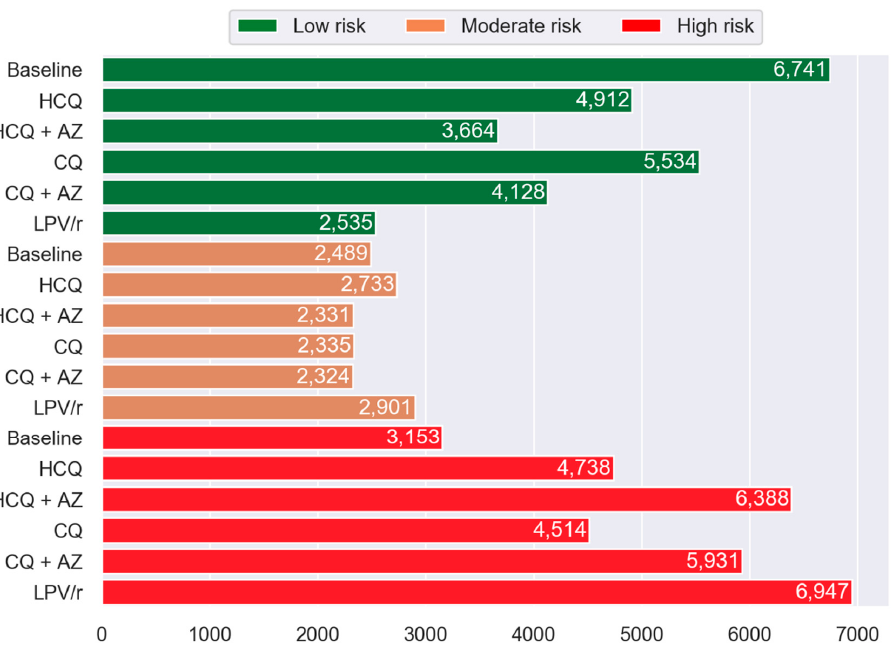
Figure 1. Violin plots of the MedWise Risk Score™ at baseline and after the virtual addition of repurposed drugs into Programs of All-inclusive Care for the Elderly (PACE) participants’ drug regimens. The white dots are the medians, and the colored areas are probability density estimates. p <0.0001 compared to the baseline for all repurposed drugs. Abbreviations: HCQ, hydroxychloroquine; AZ, azithromycin; CQ, chloroquine; and LPV/r, lopinavir + ritonavir.